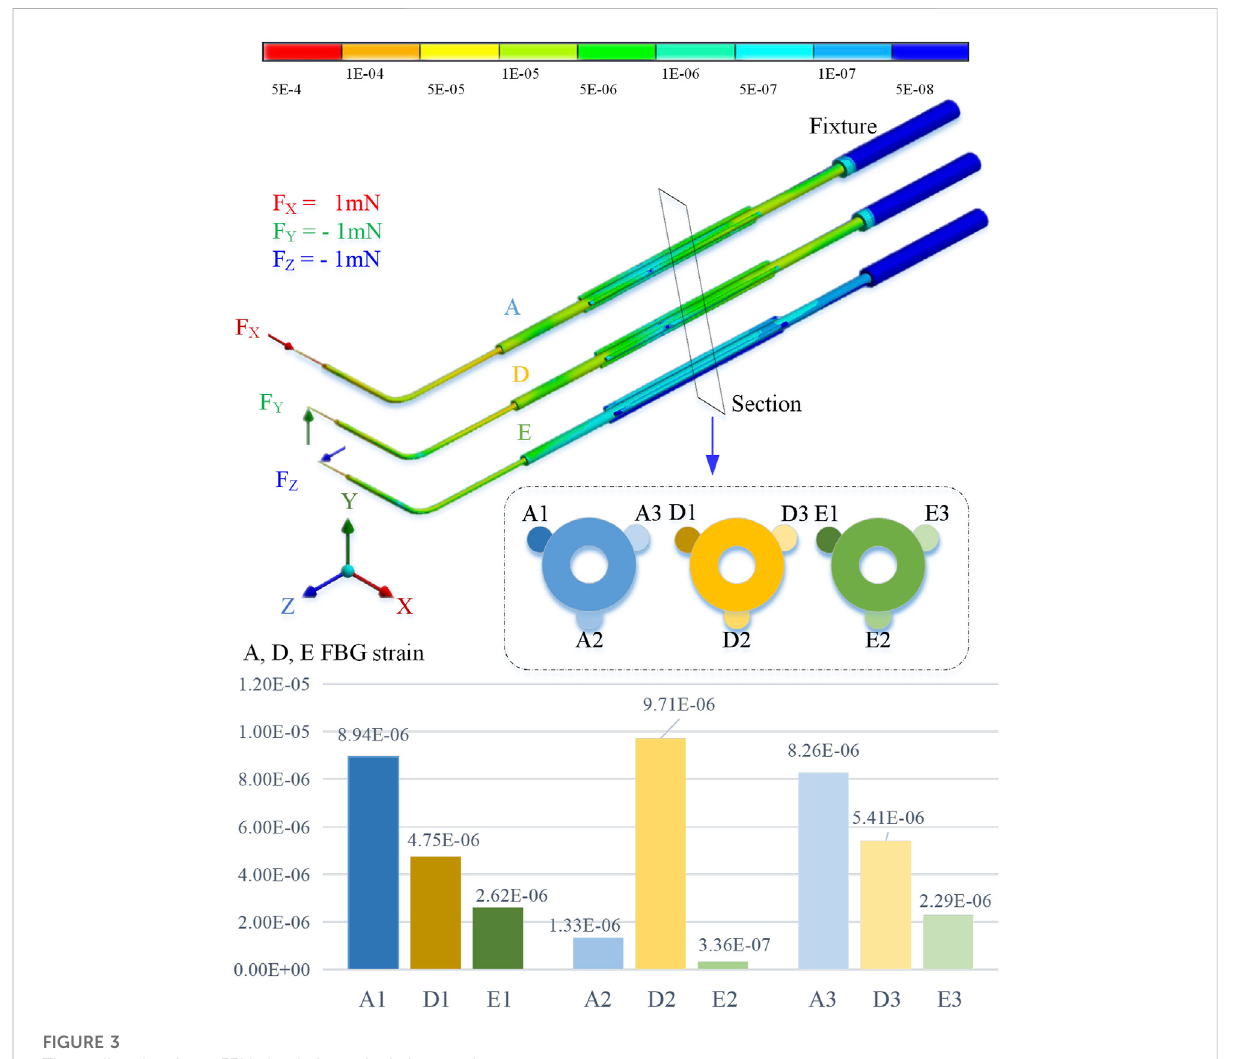
FIGURE 3 Three-direction force FEM simulation calculation